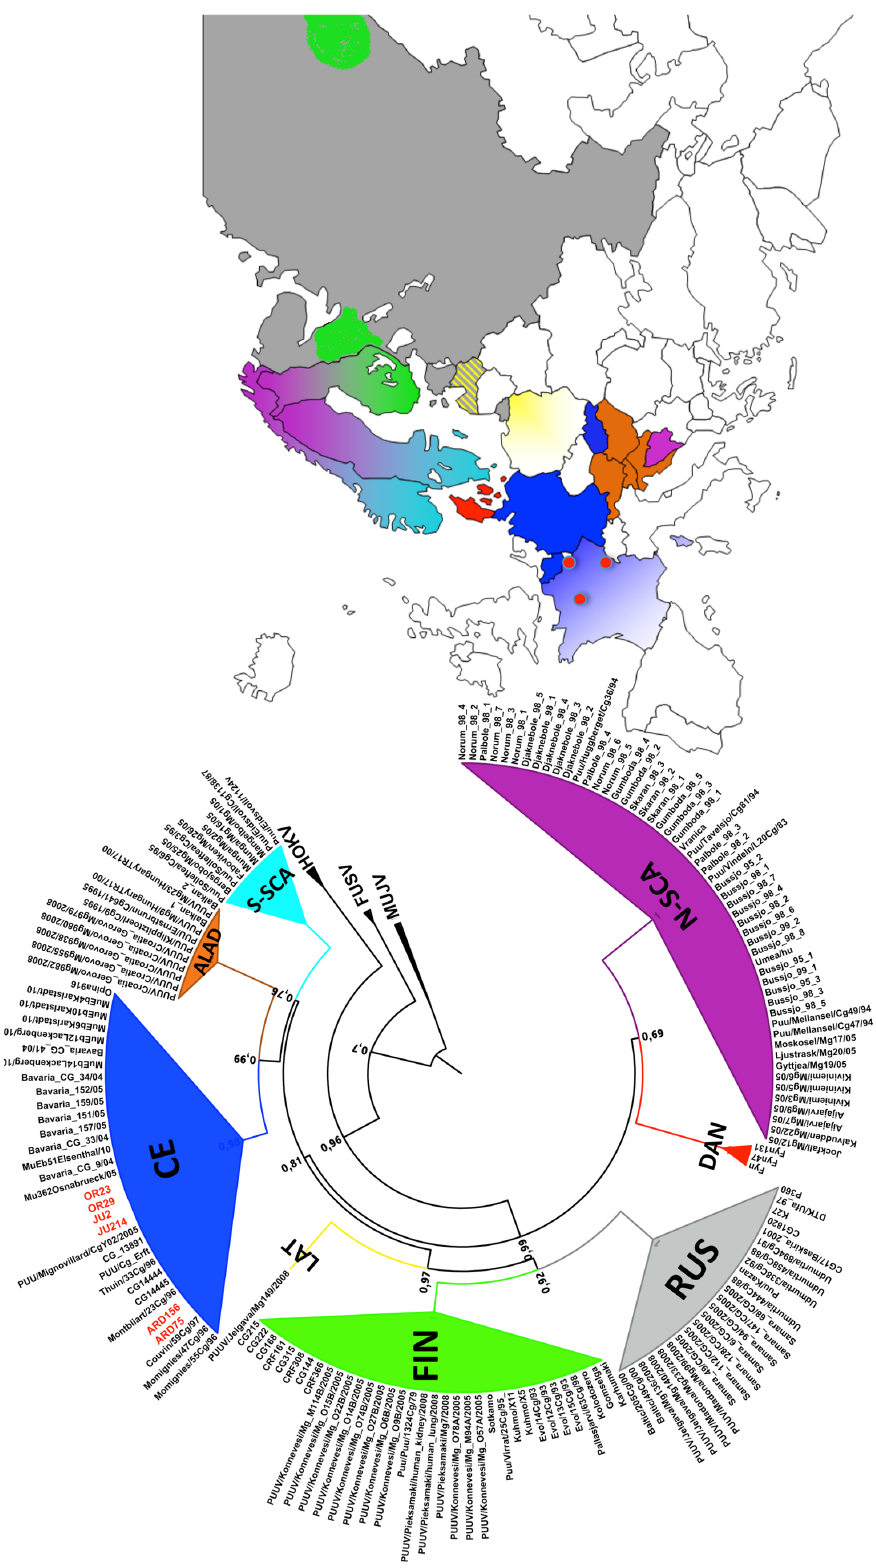
Figure 1. Circular phylo-tree based on the complete N protein coding sequences (the S segment N-open reading frame (ORF)). The same colors are used for the known Puumala virus (PUUV) lineages and their respective countries of origin on the map. French PUUV from this study are highlighted in red on the tree and red points on the map indicate their geographic localizations.